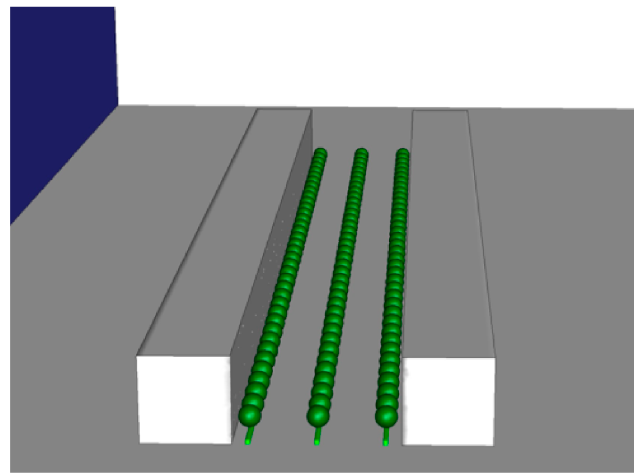
Figure 5. Illustration of the computational fluid dynamics (CFD) simulation model design applied in this study.